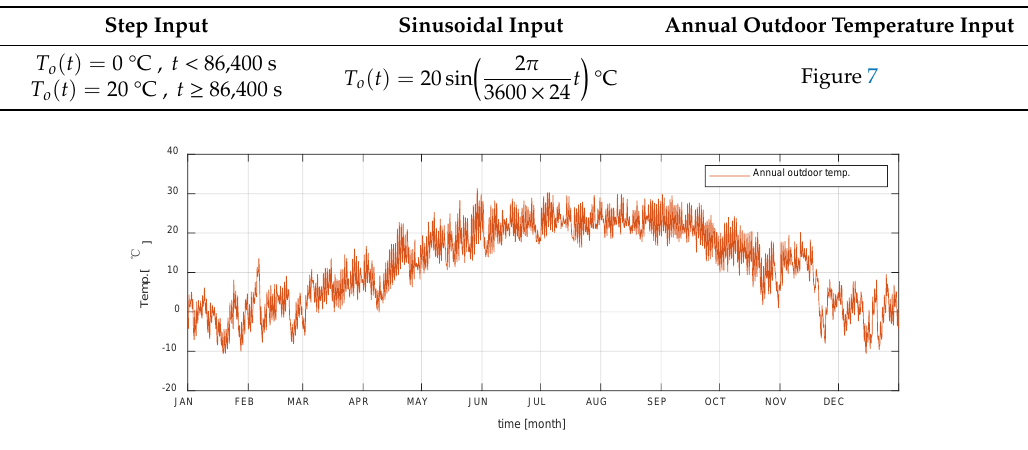
Figure 7. Annual outdoor temperature input.